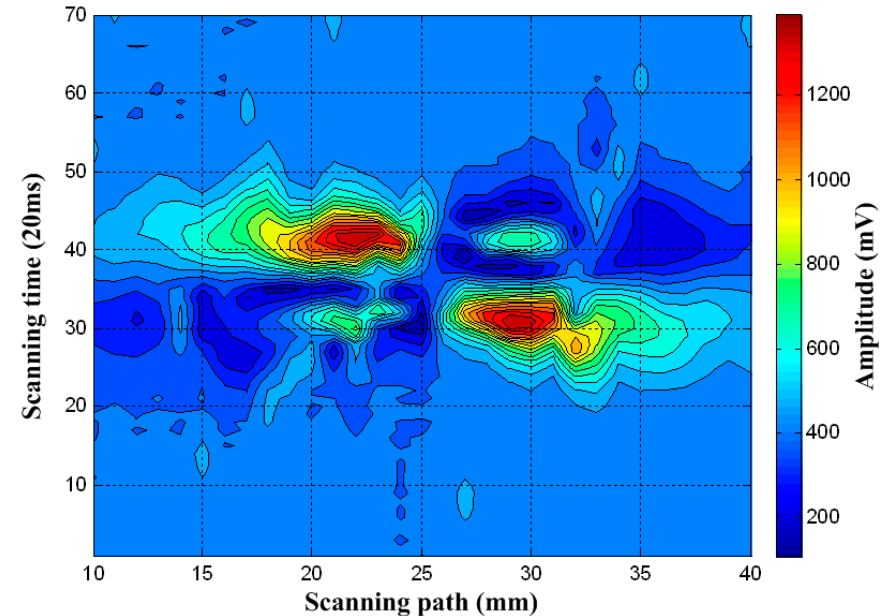
Figure 6. The original C-scan contour images of defect 1.